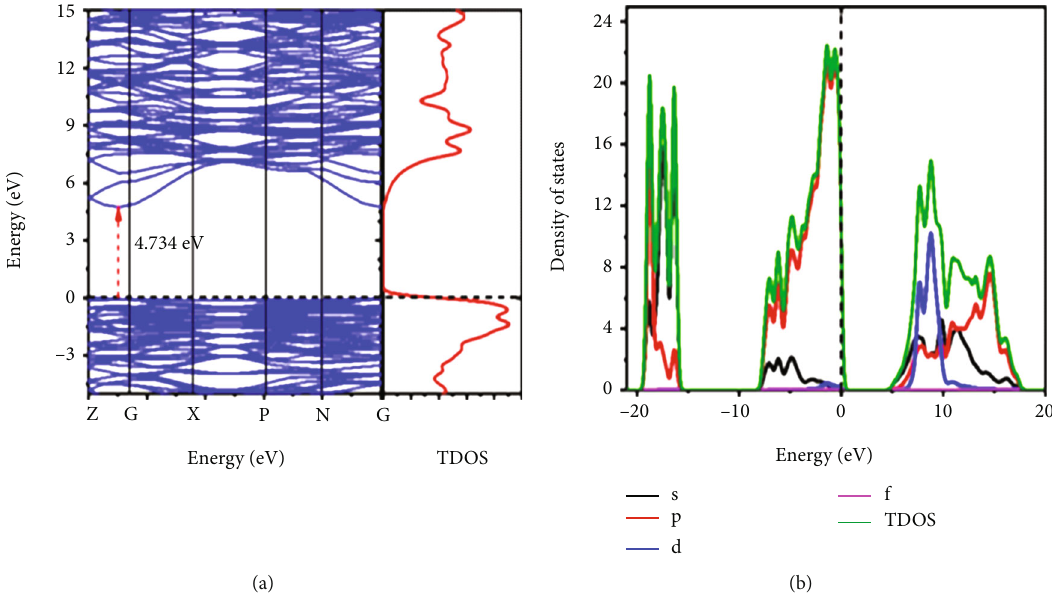
· 9H Al Si O O). 2 4 4 16 2